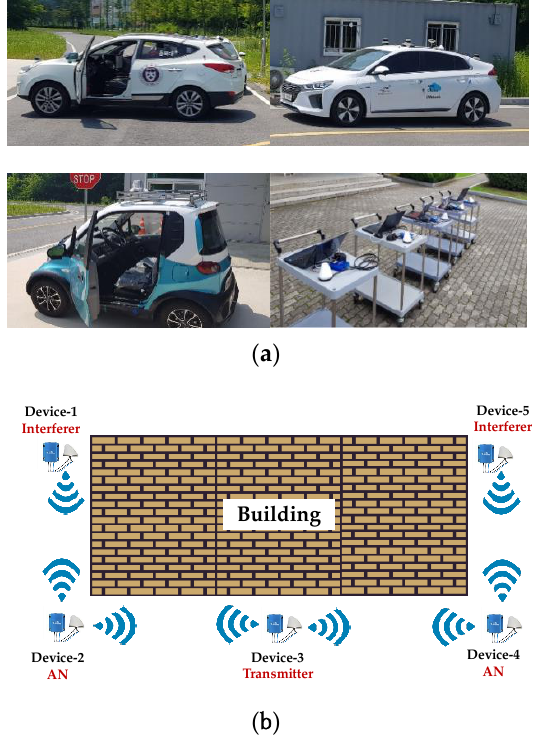
Figure 9. A testing scenario with real OBU devices: ( a ) OBUs with omnidirectional antennas are installed in the cars and hand-carrying carts; ( b ) a layout of five OBUs placed around the building.